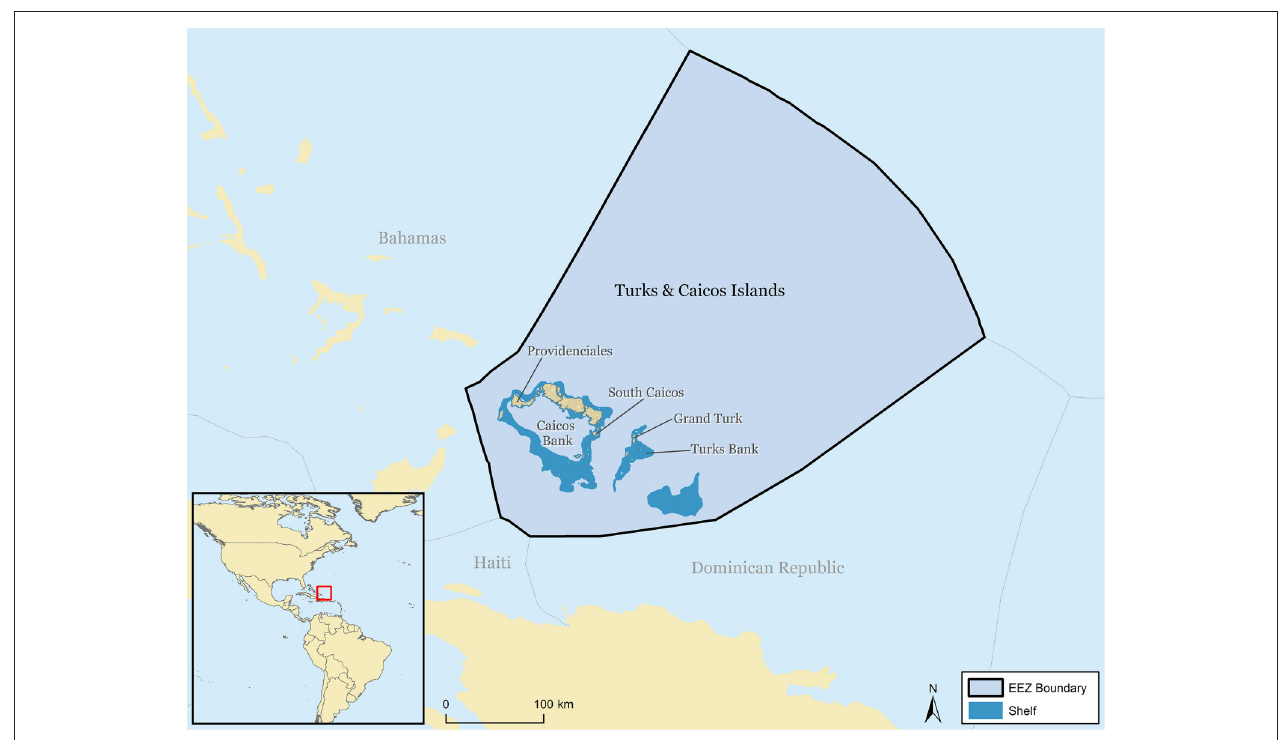
FIGURE 1 | The Exclusive Economic Zone (EEZ) and continental shelf (to 200m depth) of the Turks and Caicos